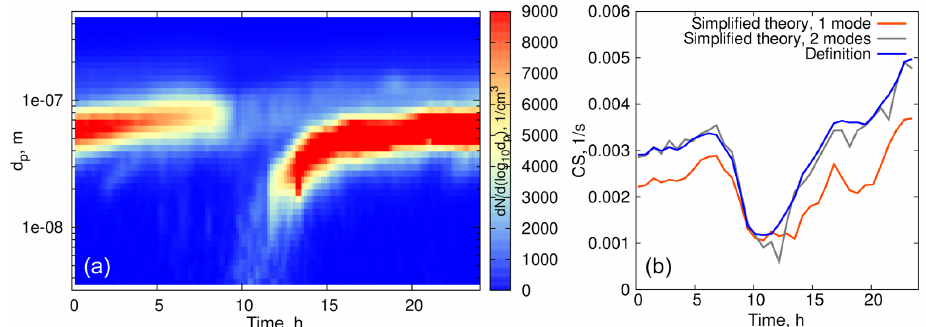
Figure 7. (a) Particle number distribution on 24 July 2008. (b) Time evolution of the condensation sink below 500nm. Blue curve: calculated from the definition, orange curve: calculated using formula (16) for one mode, gray curve: calculated using formula (16) for two modes.